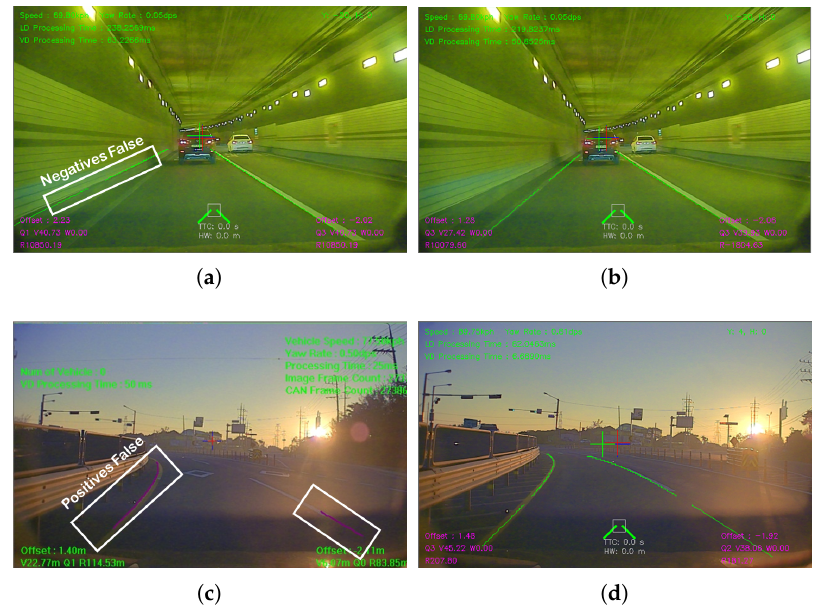
Figure 19. Test results for edge detection and tracking process improvements: ( a ) entering tun- nel condition (without illumination data), ( b ) entering tunnel condition (with illumination data), ( c ) side-light driving situation (without illumination data), and ( d ) side-light driving situation (with illumination